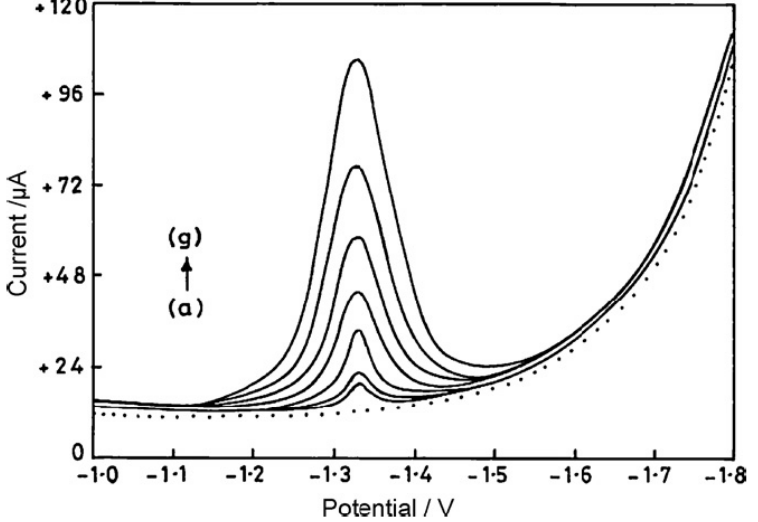
Figure 1. Osteryoung square-wave voltammograms recorded for (a) PBS (background) at the bare EPPGE ( ·· · ) and (b) increasing concentration of HC at the bare EPPGE electrode (—). Curves were recorded at (a) 100 nM, (b) 250 nM, (c) 500 nM, (d) 750 nM, (e) 1000 nM, (f) 1500 nM and (g) 2000 nM concentration in PBS of pH 7.2. Reprinted from A comparison of edge- and basal-plane pyrolytic graphite electrodes towards the sensitive determination of hydrocortisone , Talanta, Vol 83, Rajendra N. Goyal, Sanghamitra Chatterjee, Anoop Raj Singh Rana, Pages 149–155, 2011, with permission from Elsevier